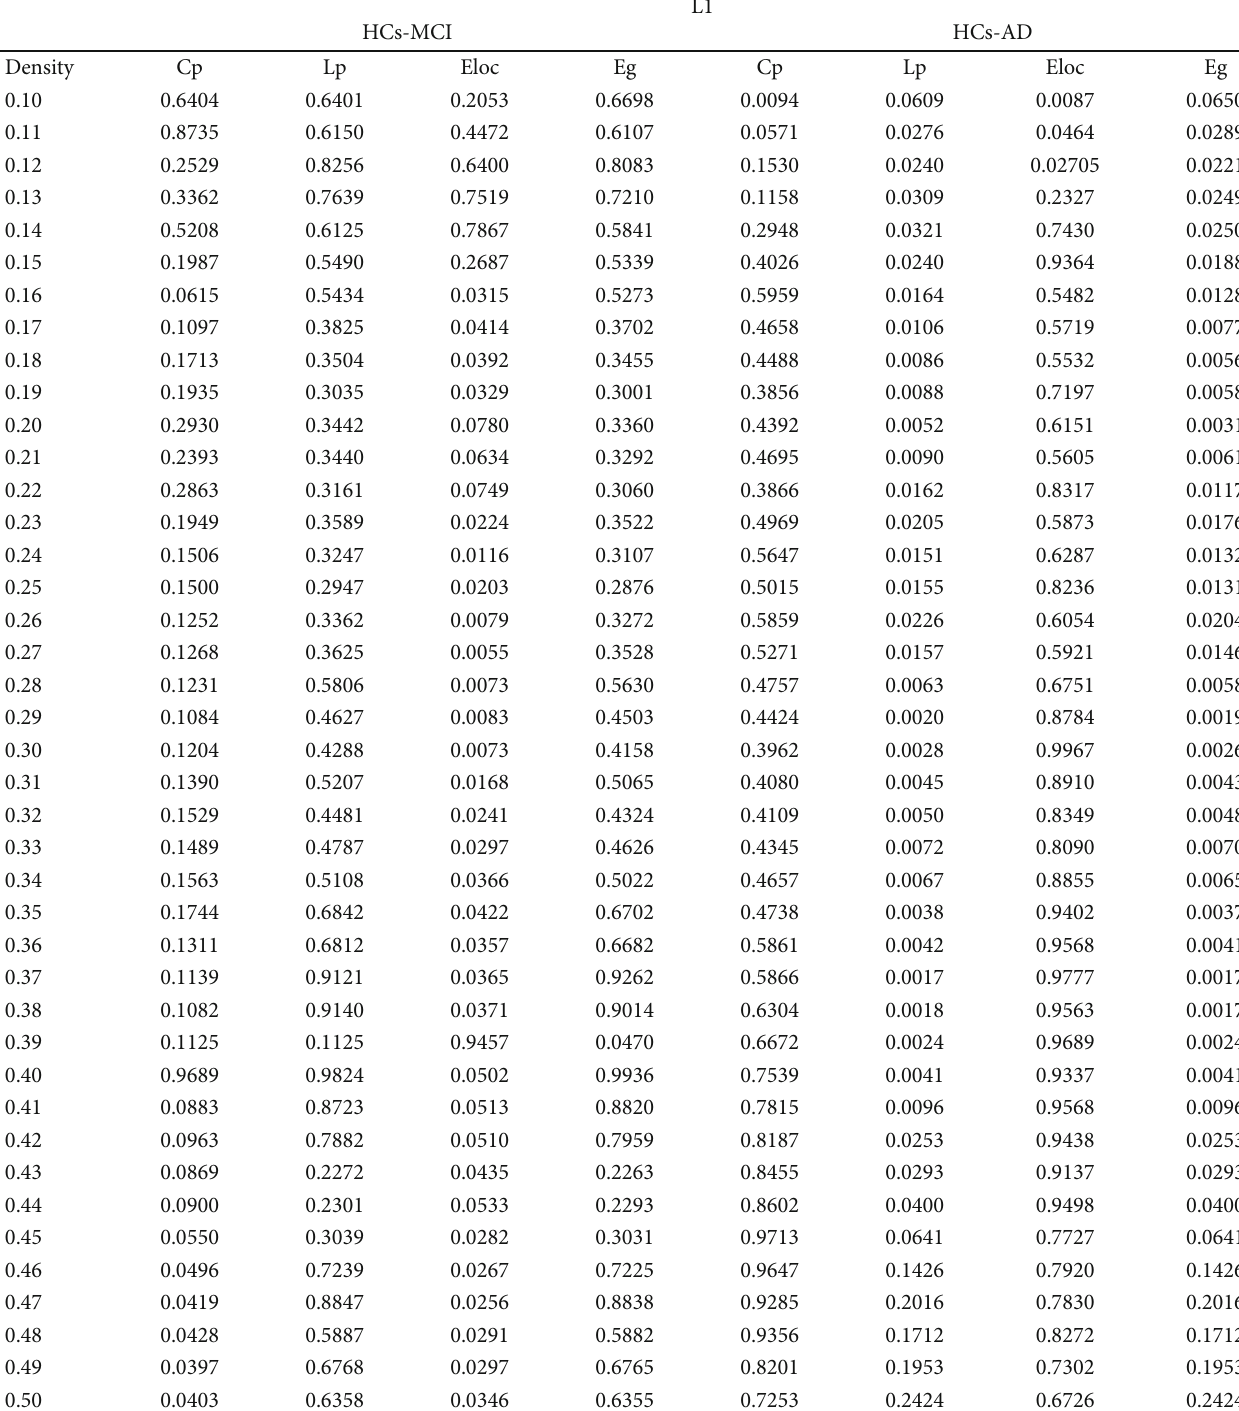
Table 4: P values of statistical tests on the small-world parameters using L1-norm